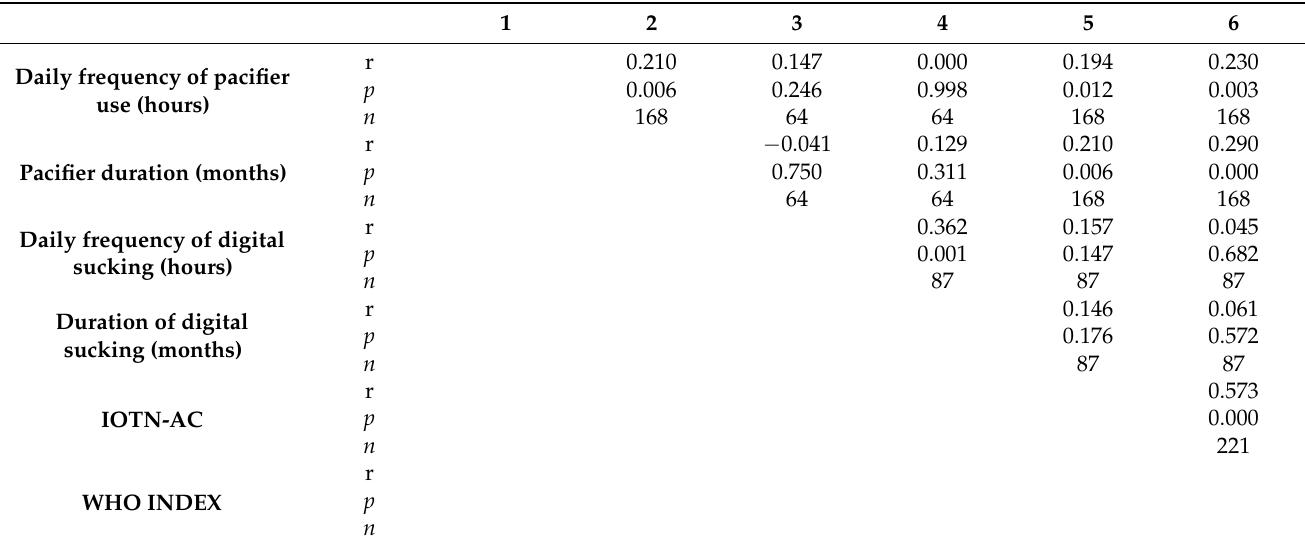
Table 3. Pearson’s correlation between pacifier (duration and daily frequency), digital sucking (duration and daily frequency), IOTN-AC and WHO index.